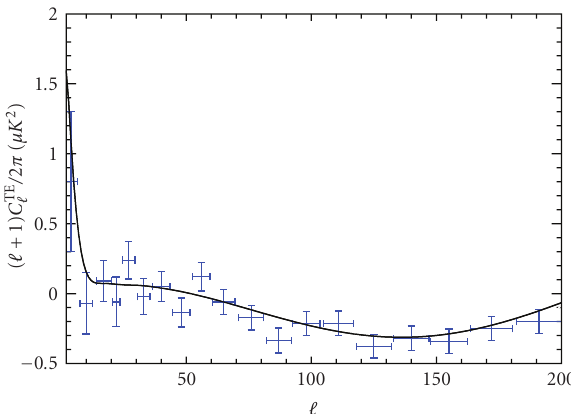
Figure 1: The solid black line is the TE cross-correlation power spectrum predicted by the Λ CDM model with no PGWs, which is the best fit for all WMAP5 data. This plot also shows WMAP5 results for TE cross-correlation with error bars (blue